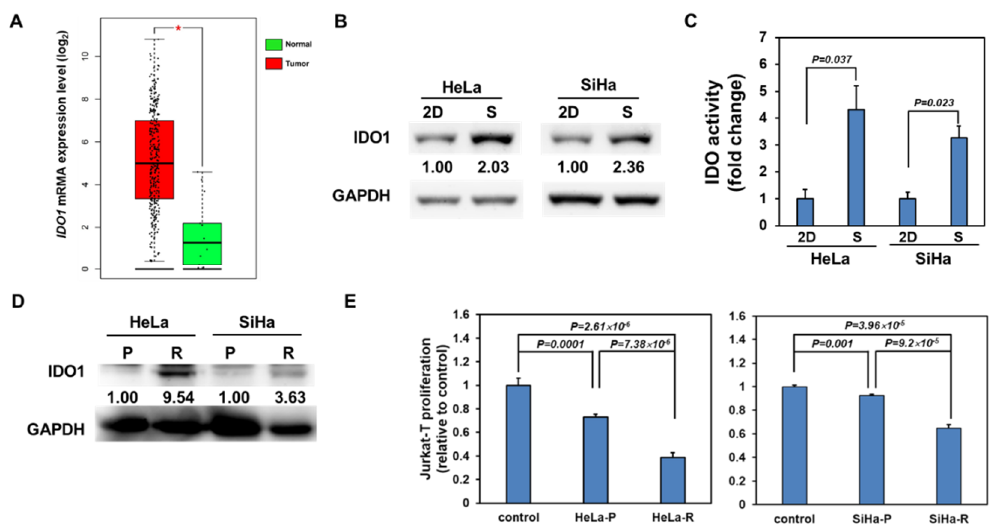
Figure 1. Indoleamine 2,3-dioxygenase 1 (IDO1) is upregulated in cervical cancer stem cells (CSCs) and irradiated cervical cancer cells. ( A ) The expression levels of IDO1 mRNA among normal cervical or cervical cancer tissues were analyzed by the Gene Expression Profiling Interactive Analysis (GEPIA) website using the data of the Cancer Genome Atlas (TCGA). * p < 0.01. (B, C) The total cell proteins were harvested from HeLa and SiHa cells under 2-dimensional culture (2D) or tumorsphere culture (S). The IDO1 protein expression was determined by Western blotting ( B ). The inserted numbers indicated the relative expression level of S in comparison to 2D. The IDO1 activity was determined by the conversion of kynurenine from tryptophan using Ehlrich reagent and measured the absorbance at 492 nm ( C ). The data were presented as fold change to 2D group. ( D ) The total cell proteins were harvested from parental (P) or irradiated (R) HeLa and SiHa cells and the IDO1 protein expression was determined by Western blotting. The inserted numbers indicate the relative expression level of R in comparison to P. ( E ) The culture supernatant of parental (P) or irradiated (R) HeLa and SiHa cells was mixed with RPMI-1640 medium at a ratio of 1:1 and used for examining the T cell suppression effect by measuring the proliferation of Jurkat T cells. The control indicated the mixture of fresh DMEM medium and RPMI-1640 medium.